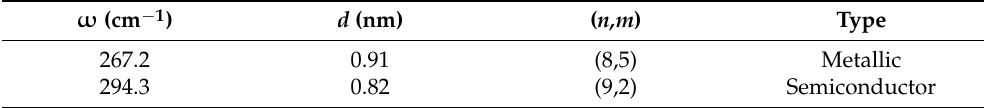
Table 1. RBM frequency ( ω ) obtained from the Raman spectrum and the evaluated diameter ( d ), chiral vector index ( n,m ), and nature of the SWCNTs.